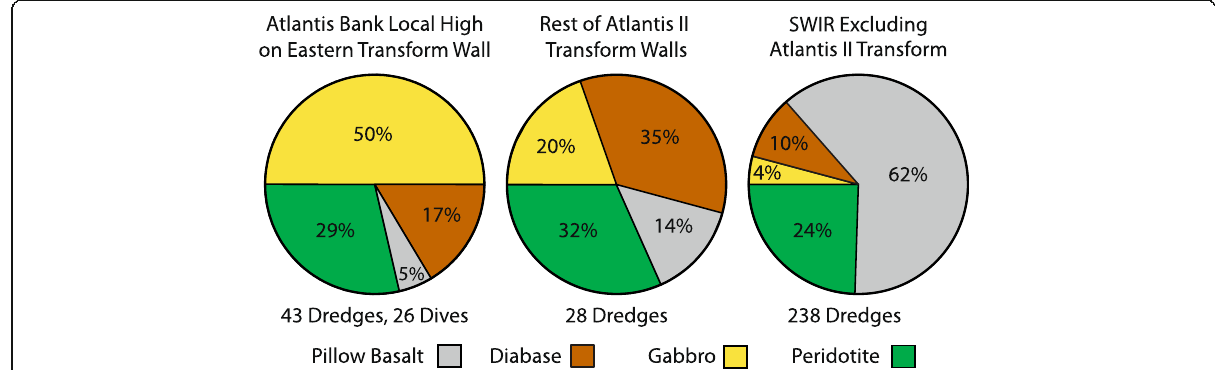
Fig. 7 Dredge statistics for the Southwest Indian Ridge, and the Atlantis II Transform walls. Percentages are calculated by the weight of material recovered. Modified from Zhou and Dick (2013). The average weight of the 868 rocks weighed and described from Atlantis Bank was 3.7 ± 5.81 kg, with a mean weight of 1.5 kg and a range from 0.01 to 48 kg. In all, some 1123 different samples by lithology were found in the 3243 kg of rock described, with numerous samples containing more than one lithology. For samples < 0.1 kg, the weight given is nominal depending on the size of the pebble. Similarly, with many of the larger samples, the weight was estimated as well. Table 2 percentages normalized to